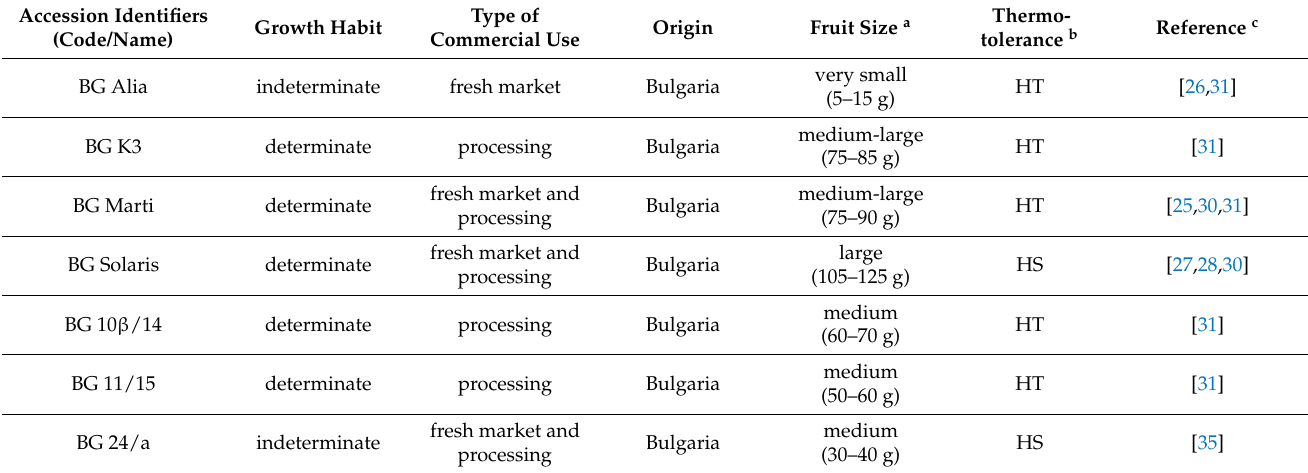
Table 1. Collection of S. lycopersicum accessions